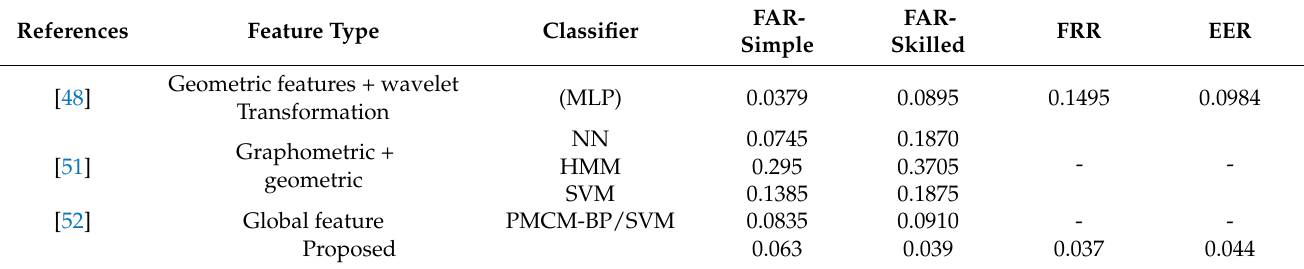
Table 10. Comparison of the results of the proposed approach and the state-of-the-art methods